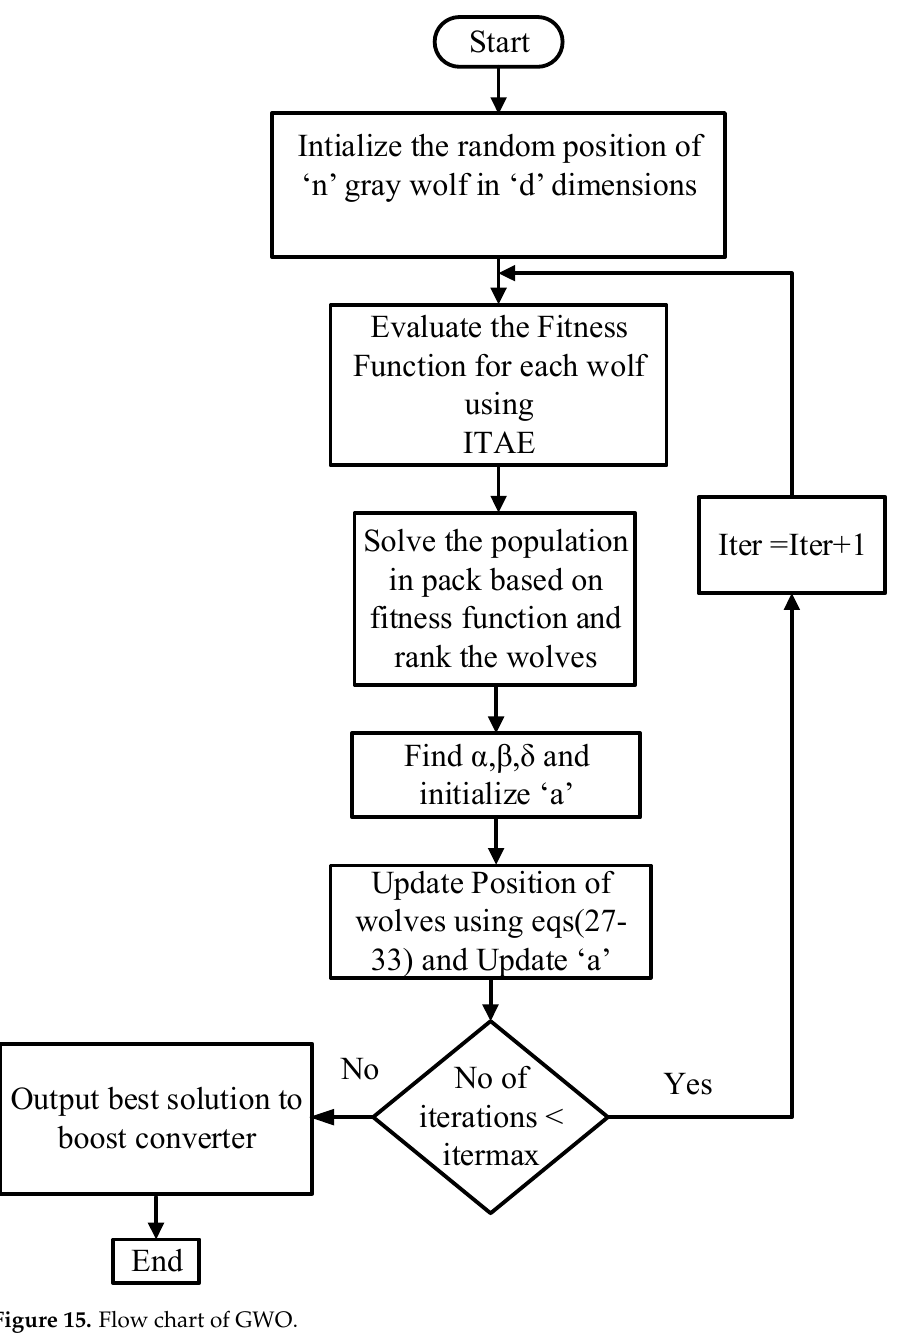
Figure 15. Flow chart of GWO.